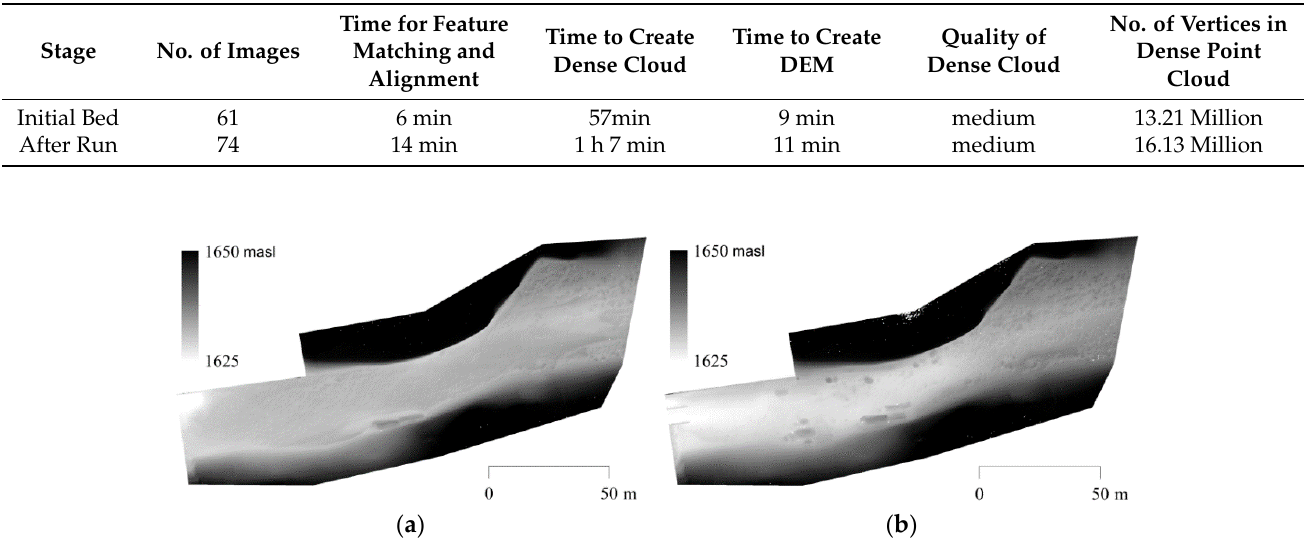
Figure 7. DEMs produced by SfM technique for Case Study II: ( a ) initial mobile bed; ( b ) final bed after flushing test.